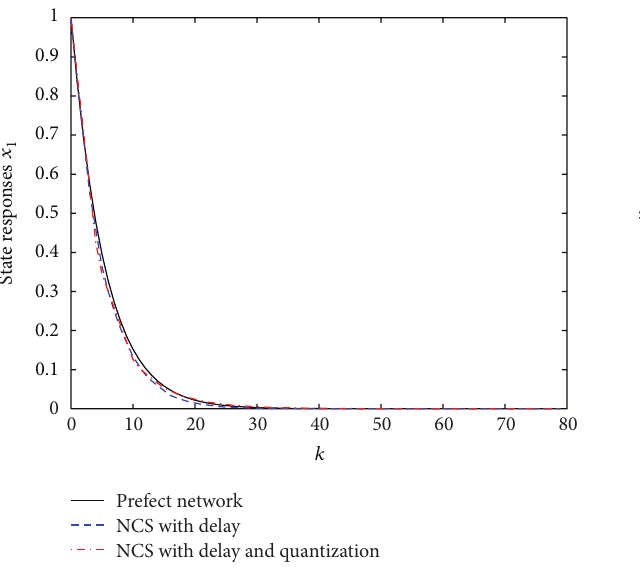
Figure 12: The state responses 𝑥 1 (Example 2).